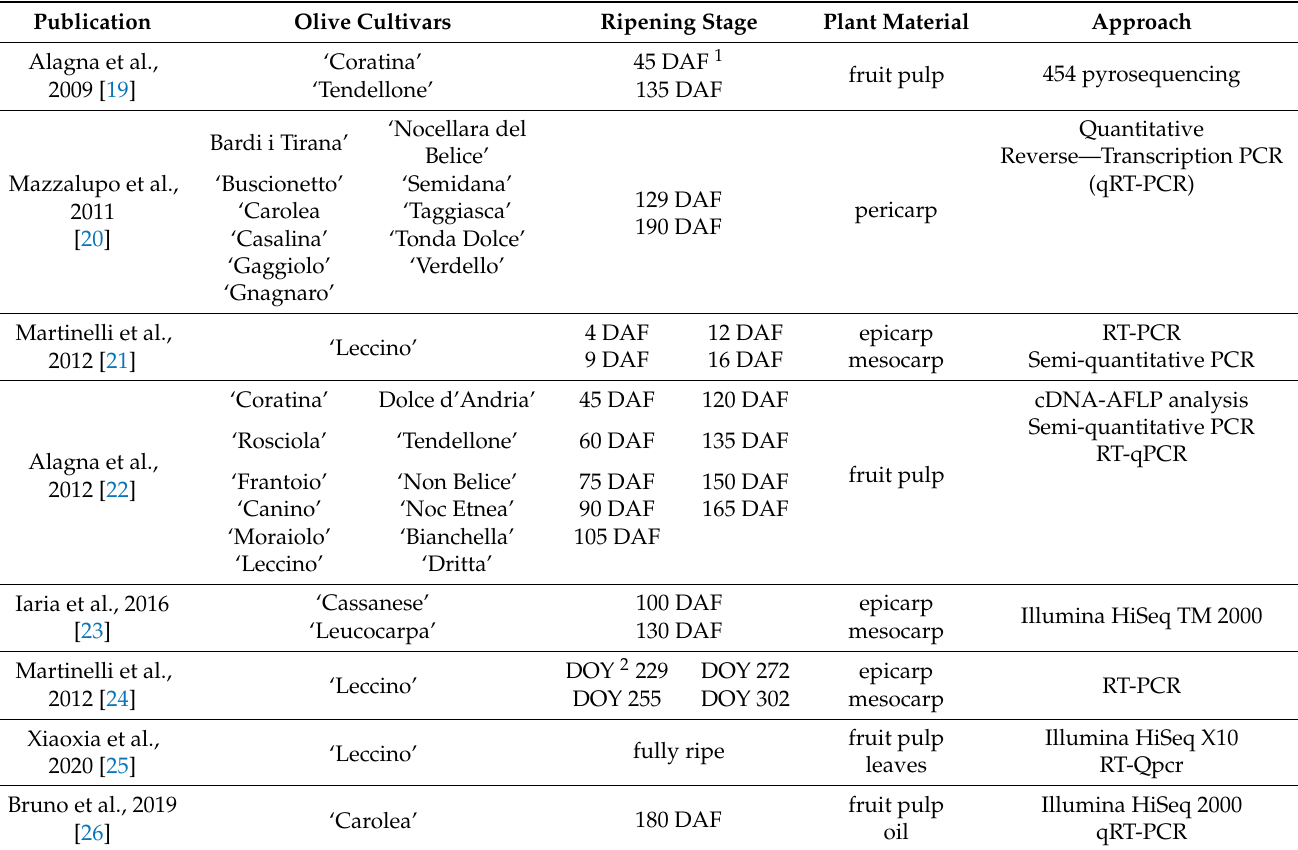
fatty acid biosynthesis and with the assembly of storage triacylglycerols was tightly linked with fatty acid accumulation pattern in olive fruits, starting at about 90 days after flowering until the end of fruit ripening. Moreover, transcripts related to the biosynthesis of structural proteins were correlated with the rapid cell divisions during fruit growth maintained the higher expression [18]. Numerous transcriptomic studies investigated the transitions occurring in a molecular basis during drupe development.